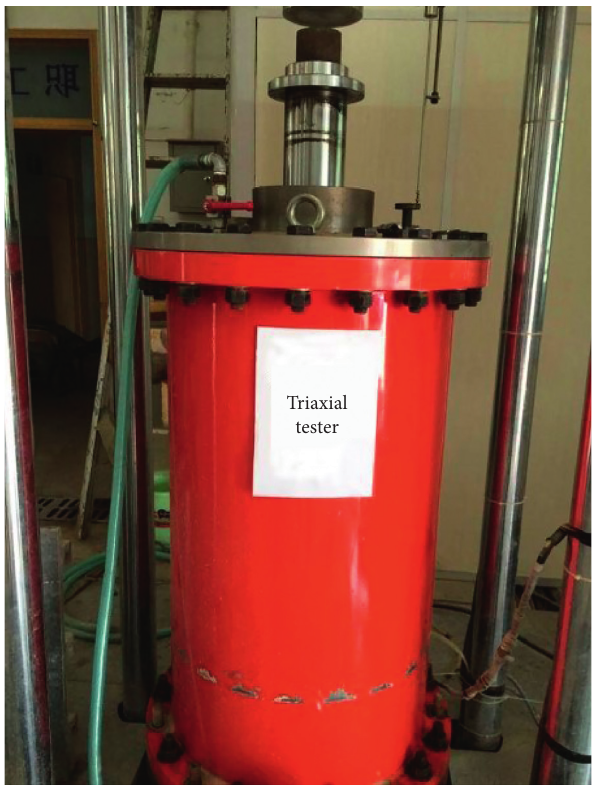
Figure 5: ST-1500-type electrohydraulic servo static triaxial tester. Table 5: Duncan–Chang E-B model calculation